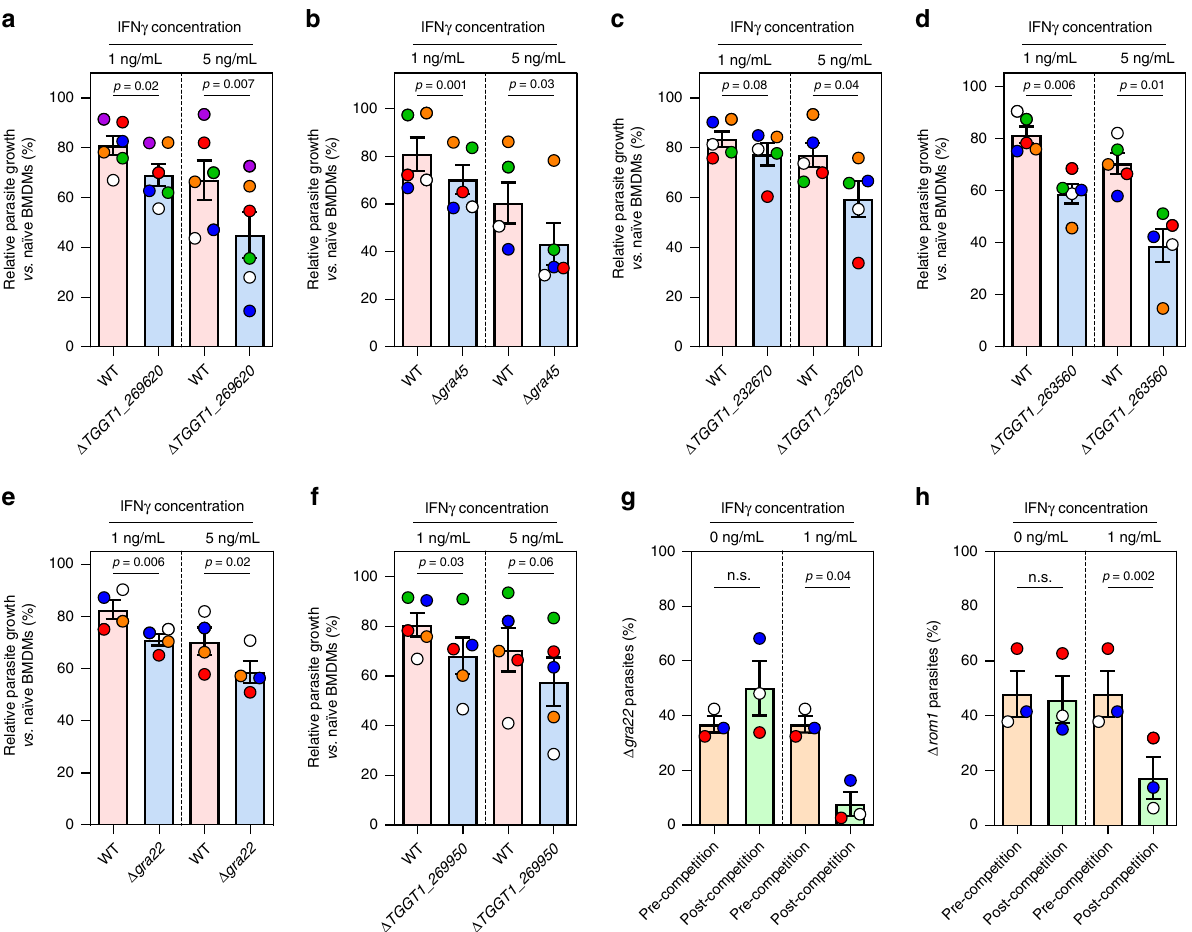
Fig. 2 Validation of candidate genes that determine parasite fi tness in IFN γ -stimulated murine BMDMs. a – f Murine BMDMs prestimulated with IFN γ (1 or 5 ng/mL) or left unstimulated for 24 h were infected with luciferase-expressing wild-type (WT) parasites or with parasites in which TGGT1_269620 ( a , n = 6), GRA45 ( b , n = 5), TGGT1_232670 ( c , n = 5), TGGT1_263560 ( d , n = 5), GRA22 ( e , n = 4), or TGGT1_269950 ( f , n = 5) was knocked out (MOI